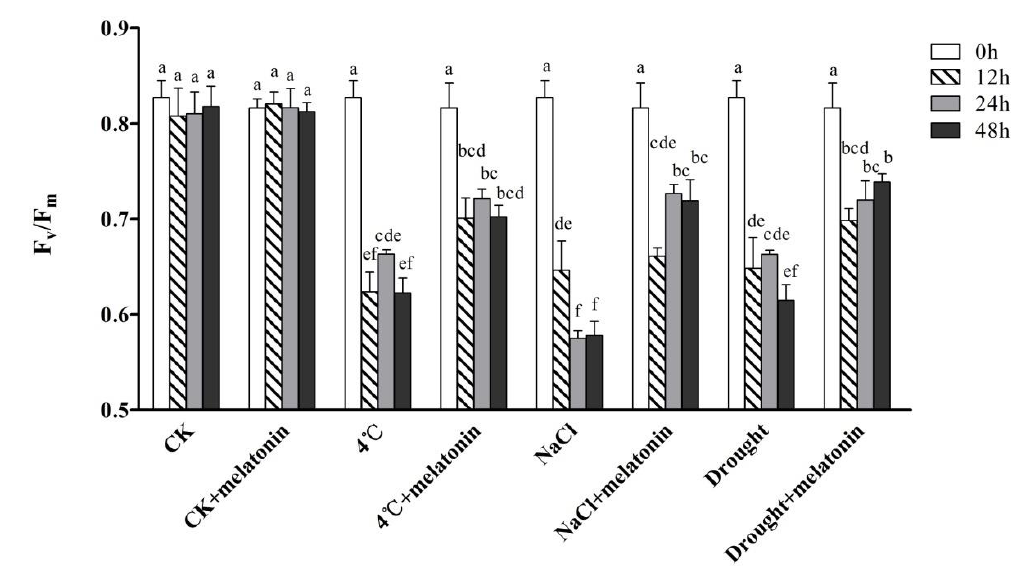
Figure 1. Effect of exogenous melatonin on photochemical efficiency of PSII (Fv/Fm) in tea leaves on the designated times. The tea plants were subjected to control (CK), cold stress (4 °C), high salt (300 mM NaCl) and drought stress (200 g·L −1 PEG) with different treatments (CK and 100 μM melatonin). All experiments were carried out at 25 °C except for cold stress (4 °C). Data represent means ± SD of three replicate samples. Different letters indicate significant differences according to Duncan’s multiple range test ( P < 0.05).